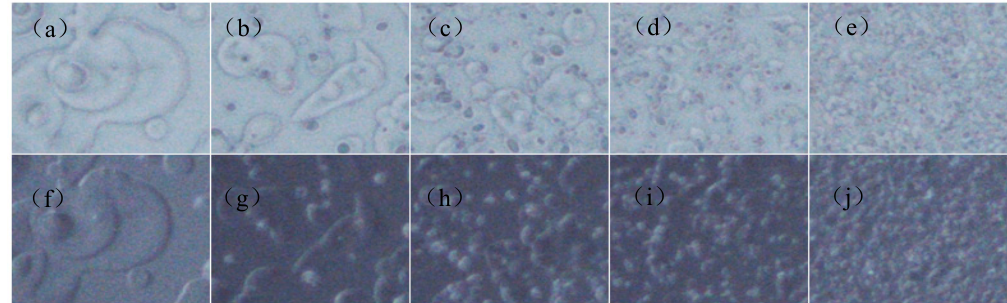
Figure 6. The digital microscope pictures of microstructure morphology of anti-glare samples by different air transport pressure ( a ) 60 kPa (90 ◦ ); ( b ) 120 kPa (90 ◦ ); ( c ) 210 kPa (90 ◦ ); ( d ) 300 kPa (90 ◦ ); ( e ) 600 kPa (90 ◦ ); ( f ) 60 kPa (25 ◦ ); ( g ) 120 kPa (25 ◦ ); ( h ) 210 kPa (25 ◦ ); ( i ) 300 kPa (25 ◦ ); and ( j ) 600 kPa (25 ◦ ) with the sol-gel deliver pressure and displacement speed of 120 kPa and 300 mm/s, respectively.